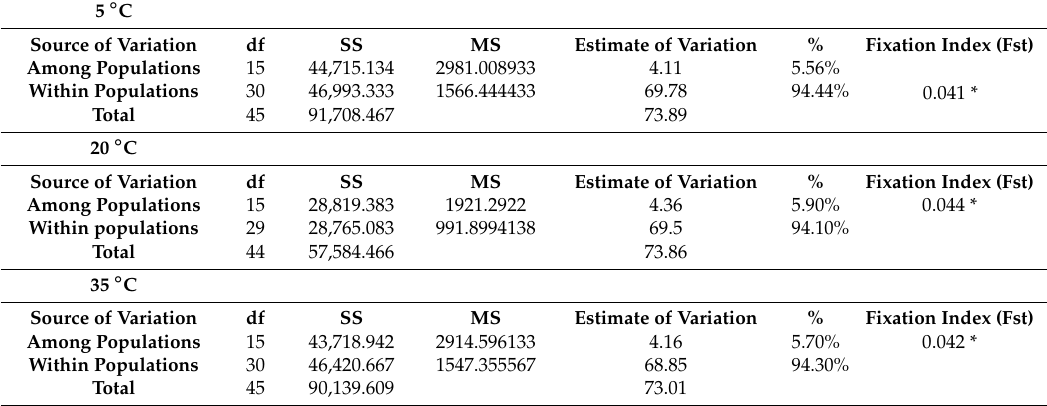
Analysis of molecular variance (AMOVA) of C. dactylon of di ff erent population at di ff erent